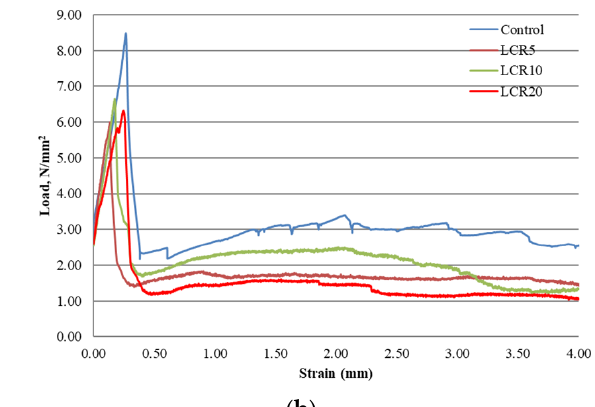
Figure 3. The change in flexural strength of concrete.